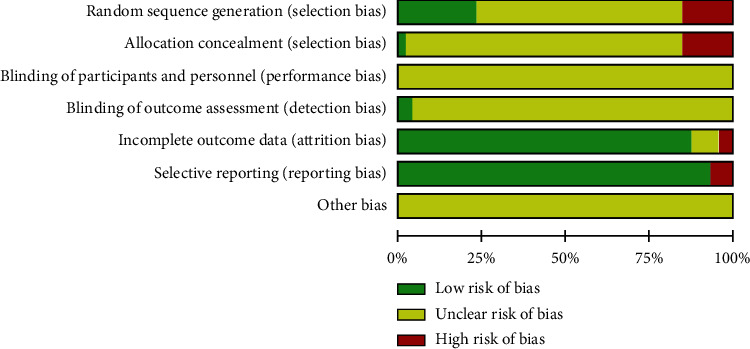
Risk of bias graph.